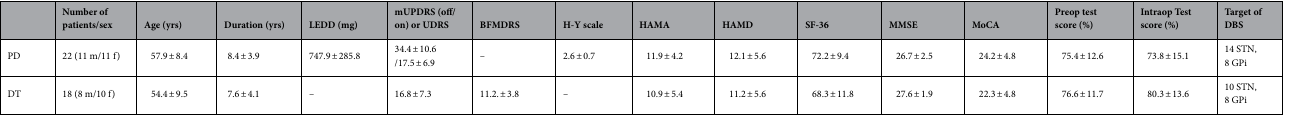
Table 1. Summary of demographic and clinical characteristics of the PD and DT patients in this